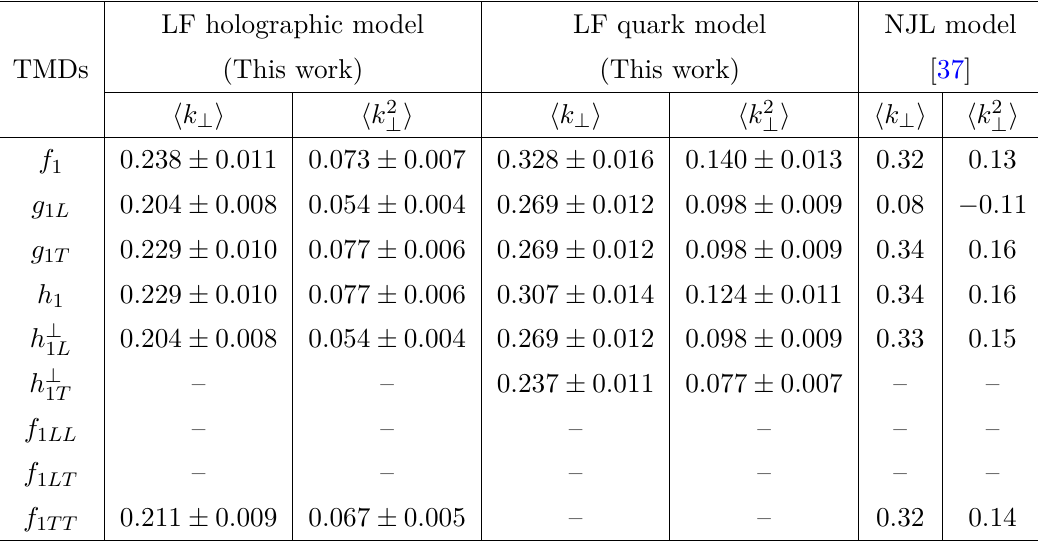
Table 2 . The first moment h k ⊥ i [in GeV] and the second moment h k 2 corresponding to several ρ -meson TMDs are compared with NJL model results [37]. The theory uncertainties result from the uncertainties in the constituent quark mass m q = 0 . 33 ± 0 . 03 GeV and the AdS/QCD scale κ = 0 . 523 ± 0 . 024 GeV in the LF holographic model whereas in the LF quark model, the values of the parameters are m q = 0 . 20 ± 0 . 02 GeV and β = 0 . 41 ± 0 . 02